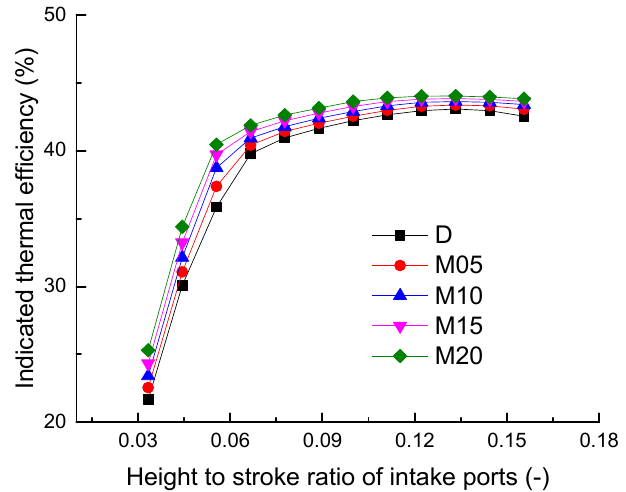
Figure 4. Indicated thermal efficiency under different HSRs of intake ports. Figure 5 indicates the NOx under different HSRs of intake ports. With the HSR of the